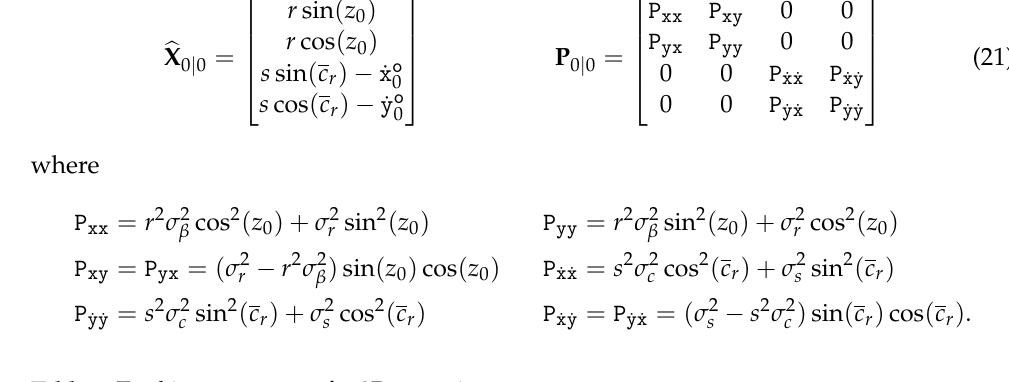
Table 1. Tracking parameters for 2D